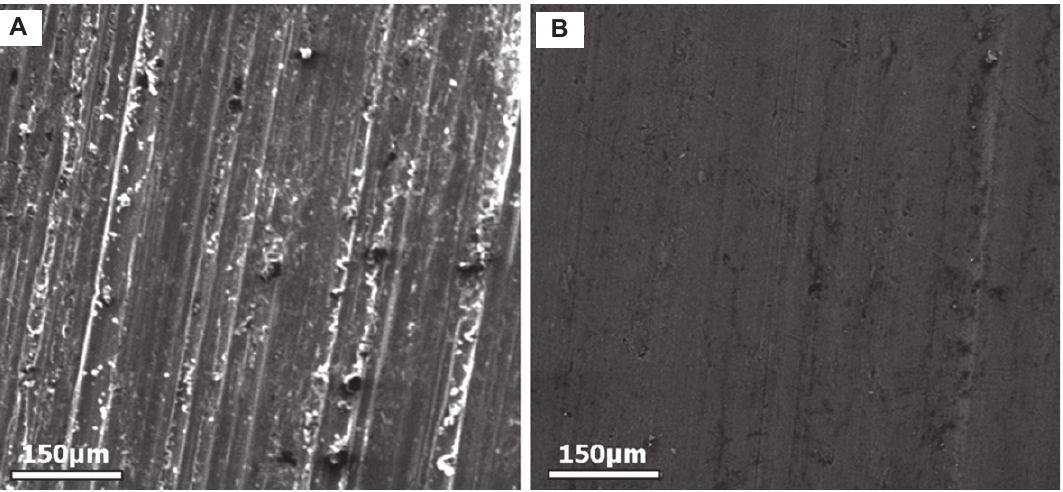
Figure 6 Worn morphologies of the TA15 substrate (A) and the composite coating